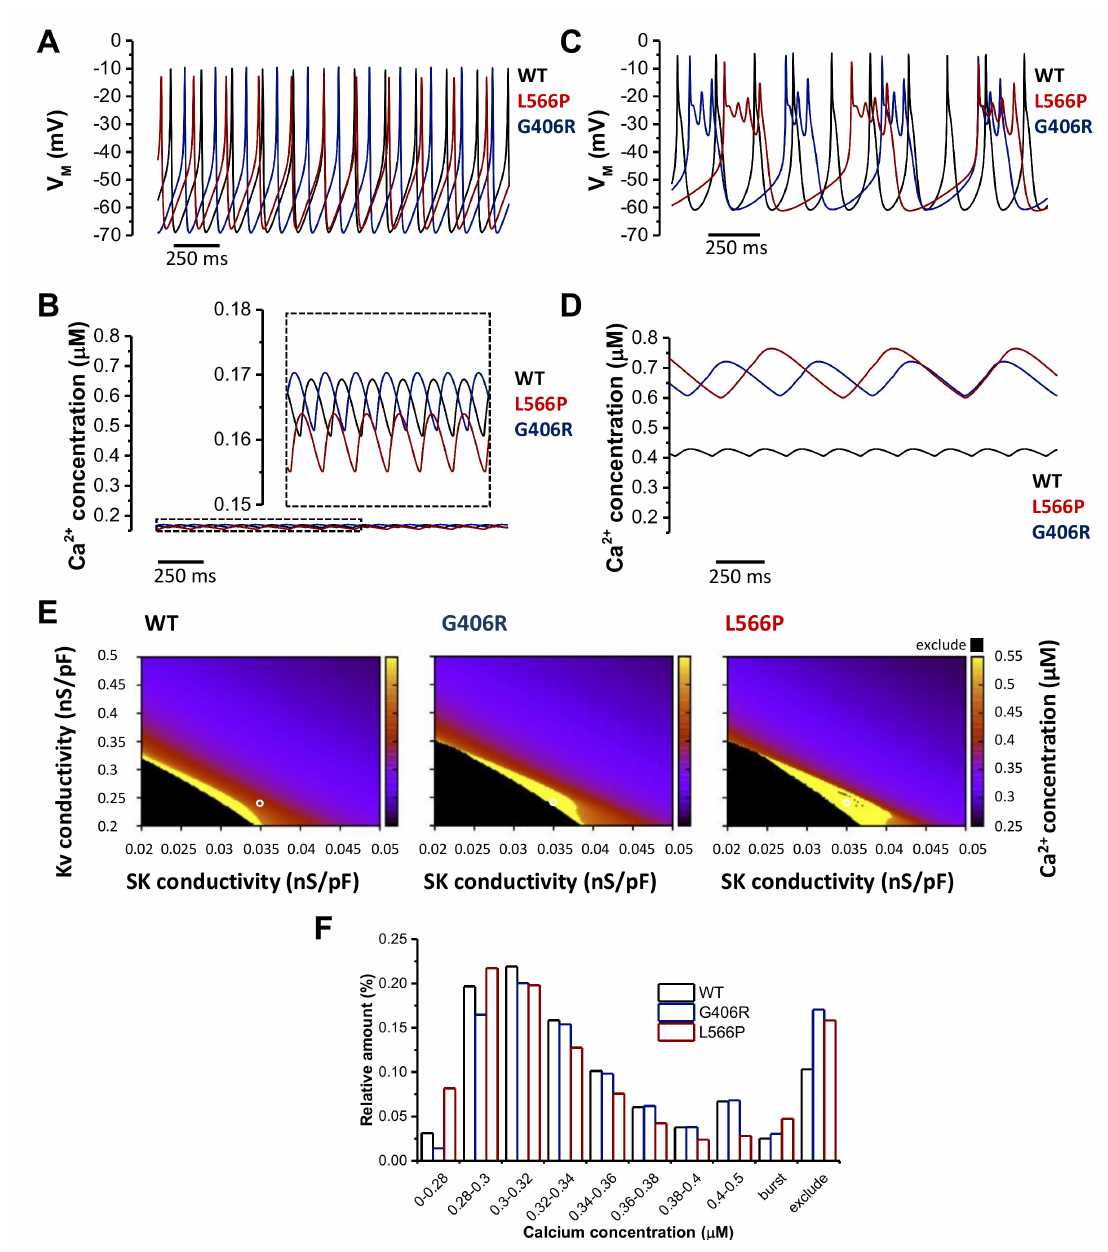
Figure 5. Computational model of the electrical activity of pancreatic beta cells for the wild-type model and the two heterozygous mutations Ca V 1.2 L566P and Ca V 1.2 G406R . ( A ) Basal transmembrane voltage (V M ) characteristics in the Riz et al. model of pancreatic beta cells of Ca V 1.2 WT (black) and for heterozygous Ca V 1.2 G406R (blue) and Ca V 1.2 L566P (red) mutations. ( B ) Corresponding basal intracellular Ca 2+ concentration oscillations. ( C ) Bursting pattern calculated using the Riz et al. model for Ca V 1.2 WT (black) and heterozygous Ca V 1.2 G406R (blue) and Ca V 1.2 L566P (red) mutations. ( D ) Corresponding Ca 2+ concentration course during bursting. ( E ) Heat map representing Ca 2+ concentration in dependence of Kv channel conductivity g Kv and SK channel conductivity g SK for the three investigated cases. Yellow areas represent the burst mode, black area cells that do not repolarize anymore with high calcium concentrations (thus excluded from the evaluation), and the remaining basal mode. ( F ) Relative distribution of the intracellular Ca 2+ concentrations for Ca V 1.2 WT and for the heterozygous Ca V 1.2 G406R and Ca V 1.2 L566P mutations calculated from the heat maps in ( E